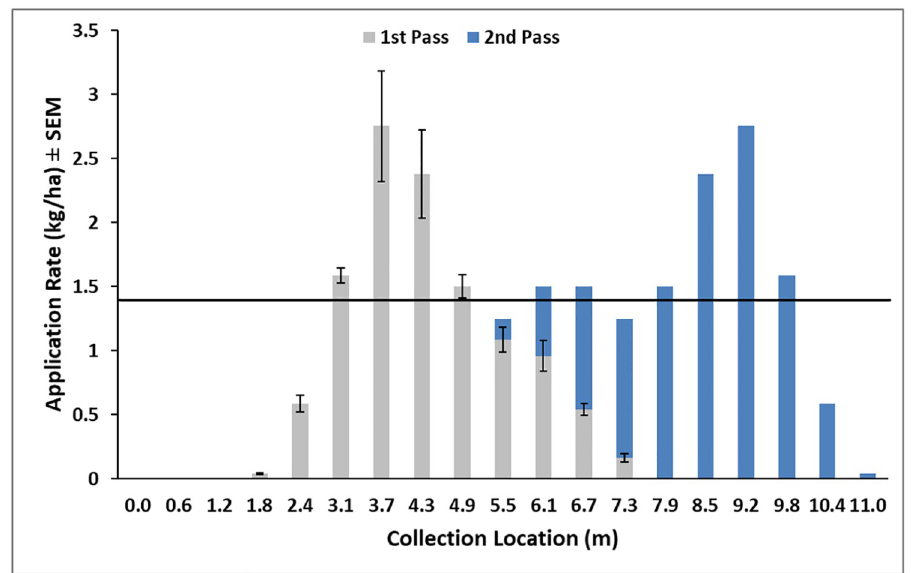
Fig 5. Swath width and application rate test of VectoPrime FG applied at a rate of 136 g/min from a DJI S1000 + UAS at 6 m altitude over a line of containers ± SEM. Each bar represents one container. Horizontal line signifies the minimum recommended application rate for VectoPrime of 1.4 kg/ha (maximum rate = 22.4 kg/ha). Gray bars illustrate one pass of the UAS. Blue bars illustrate a second pass in the opposite direction with a 1.8 m overlap. Average application rate for the plot = 1.8